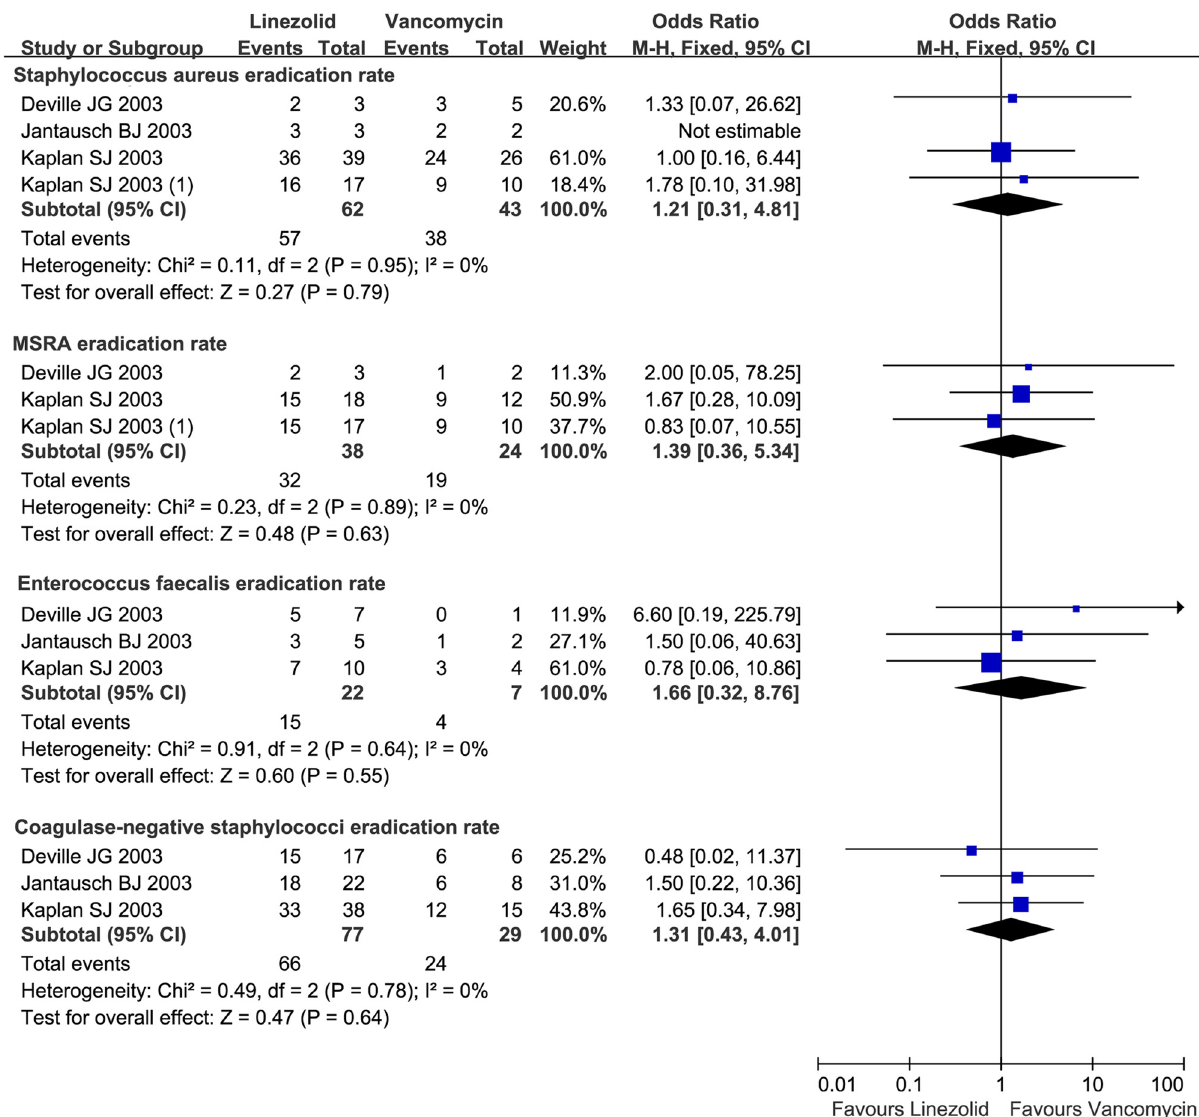
Figure 3: Pathogen eradication rate of linezolid vs. vancomycin in children (< 12 years ) with resistant Gram - positive bacterial infections. Pathogen eradication rate for S. aureus , MRSA, Enterococcus faecalis , and CoNS in microbiologically evaluable patients treated with linezolid vs vancomycin for the treatment of resistant Gram - positive bacterial infections in children under 12 years. M - H, Mantel - Haenszel; CI, con fi dential